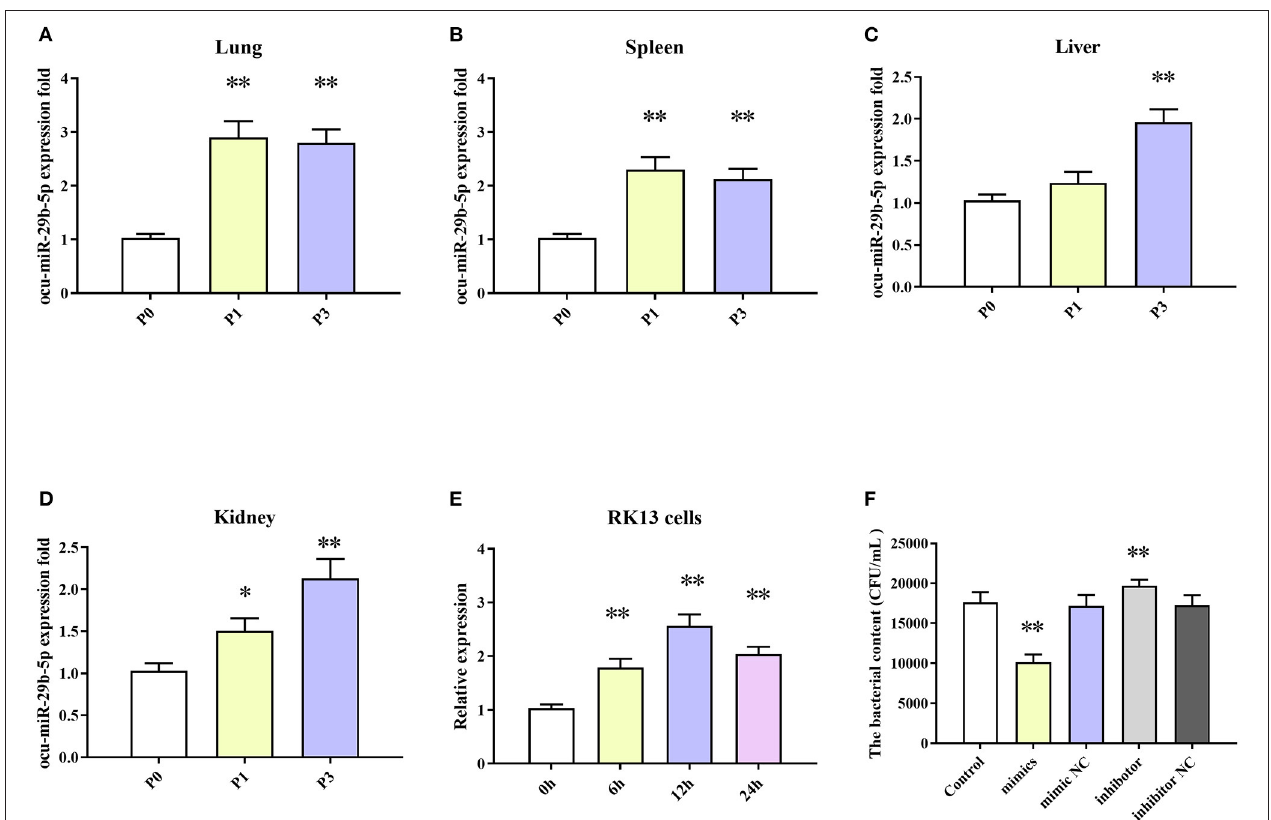
FIGURE 8 | ocu-miR-29b-5p expression profiles and effect of ocu-miR-29b-5p on the infectivity of P. multocida . The time-coures expression profiles of ocu-miR-29b-5p in the lung (A) , spleen (B) , liver (C) , kidney (D) , and RK13 cells (E) . RK13 cells were treated with P. multocida in the presence of ocu-miR-29b-5p mimics or knockdown of miR-29b-5p, and bacterial recovery from the cells was counted by plate count (F) . Values are shown as means ± SD. Compared with the P0, * P < 0.05, ** P <